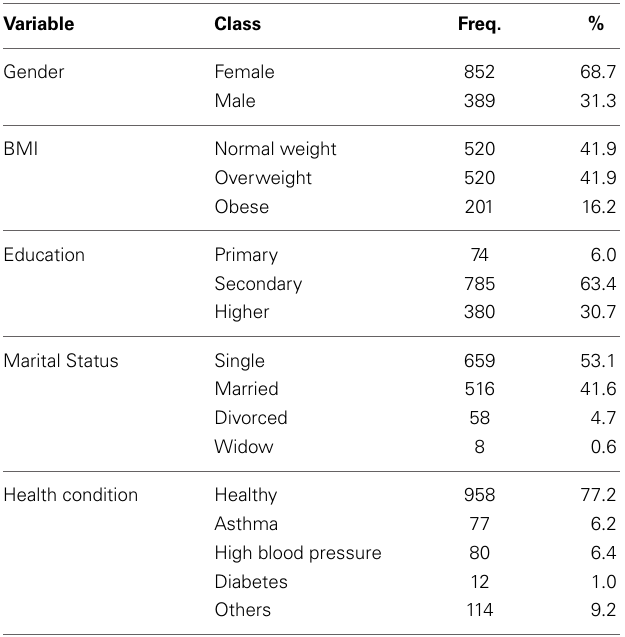
Table 1 | Socio-demographic and clinical data of the sample.